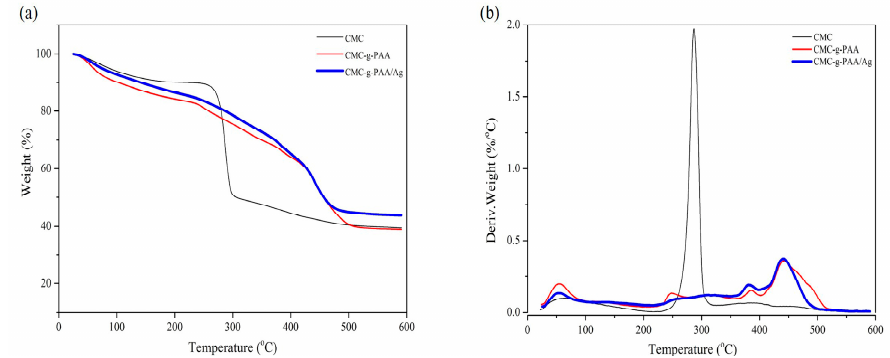
Figure 8. Thermogravimetric (TG) ( a ) and DTG ( b ) curves of CMC, CMC-g-PAA and CMC-g-PAA/Ag.